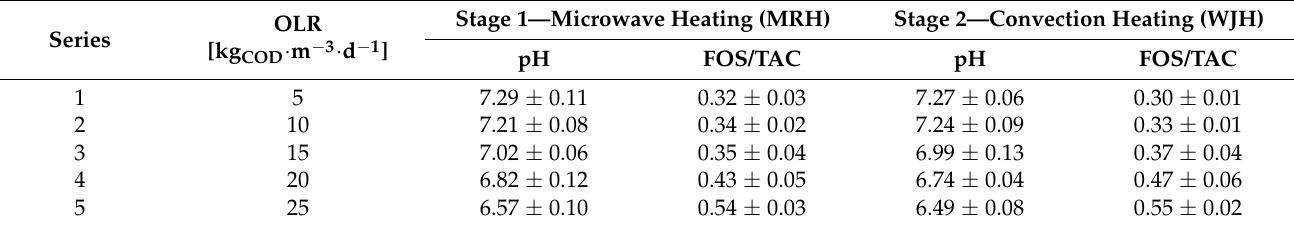
Table 4. pH and FOS/TAC values depending on the variant of the experiment.